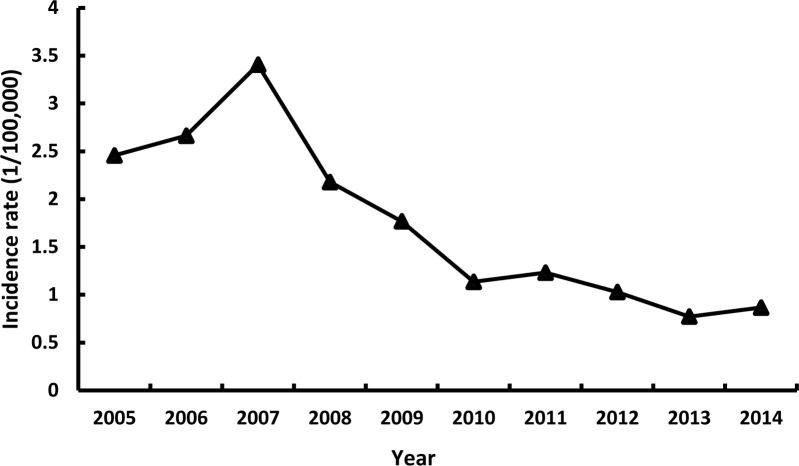
Hepatitis A incidence rate by year.